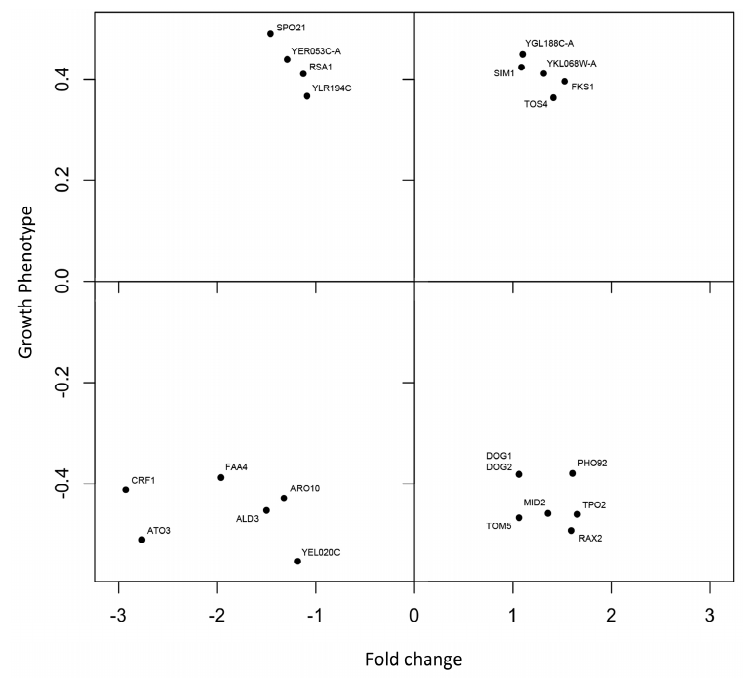
Figure 4. Scatter plot representing the comparison between the fold change (increase/decrease) in gene expression, from microarray analyses, and the growth phenotype (GP) knock-out mutant screening, expressed as tolerant and sensitive phenotypes [16].